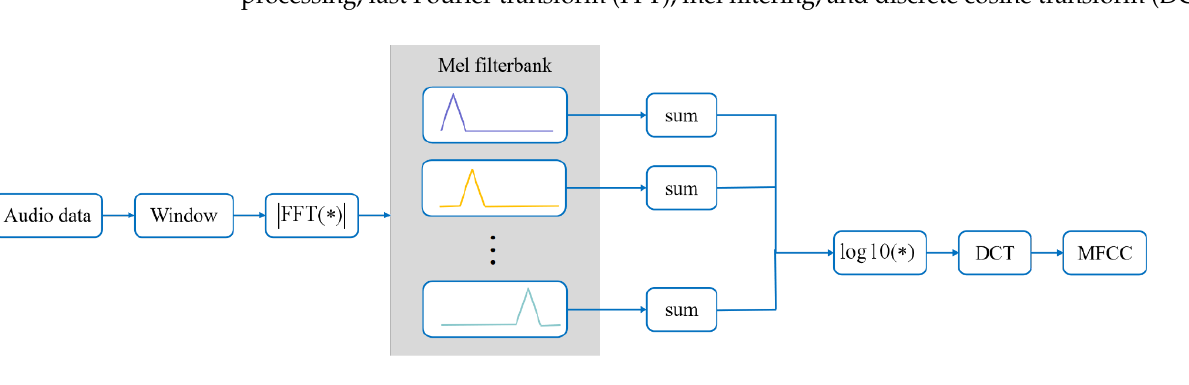
Figure 2. MFCC feature extraction flowchart.